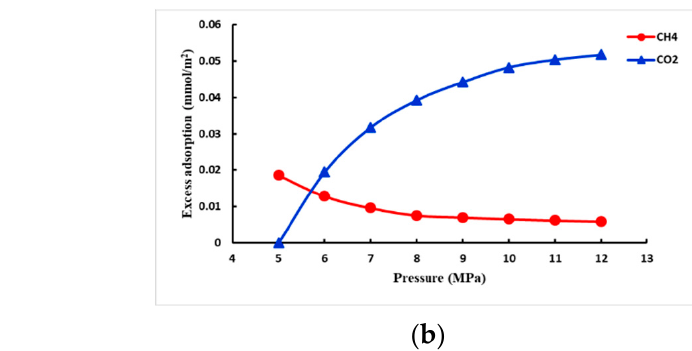
Figure 9. The adsorption capacity of two fluids ( a ): Total adsorption capacity, ( b ): Excess adsorption capacity.